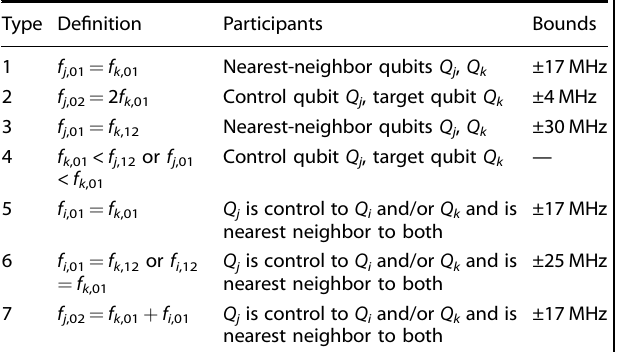
Table 1. Seven most likely types of frequency